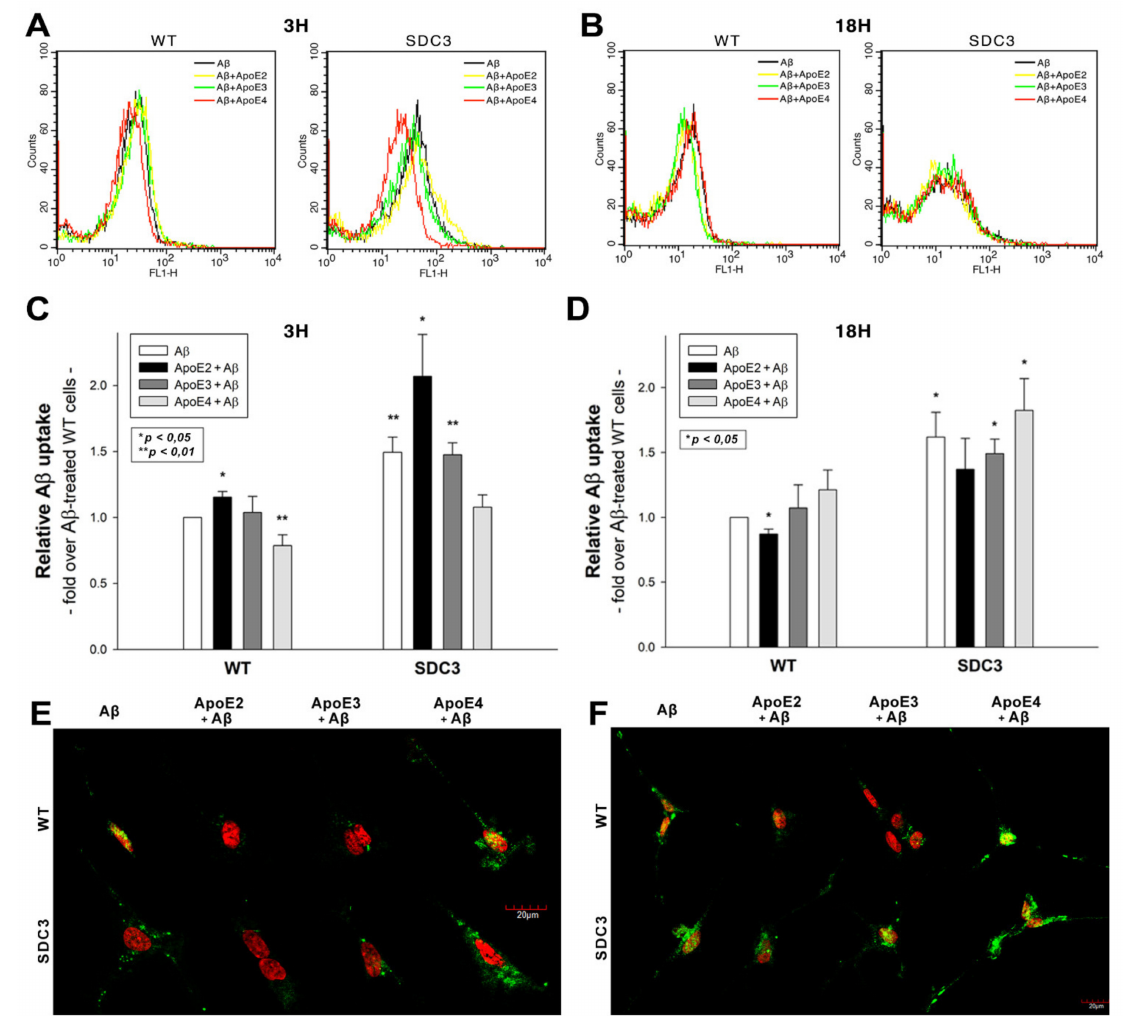
Figure 6. The effects of ApoEs on A β 1–42 uptake in WT and SDC3-overexpressing differentiated SH-SY5Y cells. WT and SDC3-overexpressing differentiated SH-SY5Y cells were preincubated with different ApoEs for 30 min at 37 ◦ C. The cells were then treated with FITC-labeled or, in case of fibrillation studies, unlabeled A β 1–42 for either 3 or 18 h. After incubation, the cellular uptake of A β 1–42 was analyzed. ( A,B ) Flow cytometry histograms representing the intracellular fluorescence of differentiated WT and SDC3-overexpressing differentiated SH-SY5Y cells treated with FITC-labeled A β 1–42 for 3 ( A ) and 18 h ( B ) in the absence or presence of ApoEs. ( C,D ) Detected intracellular fluorescence intensities were normalized to FITC-A β 1–42-only treated WT SH-SY5Y cells as standards. The bars represent the mean ± SEM of four independent experiments. Statistical significance vs. standards was assessed with ANOVA. * p < 0.05; ** p < 0.01. ( E,F ) Confocal microscopic visualization of ThT-labeled A β 1–42 fibrils in WT and SDC3-overexpressing differentiated SH-SY5Y cells at 3 h ( E ) and 18 h ( F ) of incubation. The nuclei of cells were stained with DRAQ5. Representative images of three independent experiments are shown. Scale bar = 20 µ